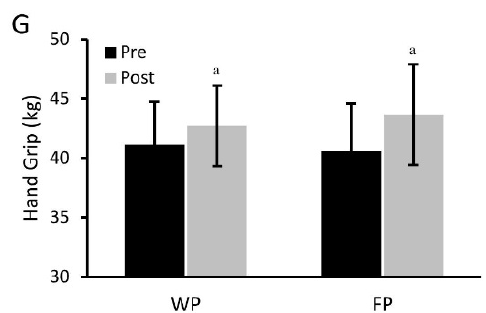
Figure 2. Comparisons of physical performance assessments between the food protein (FP) and the whey protein (WP) groups following the protein-pacing, resistance, interval, stretching, endurance training (PRISE): upper ( A ) and lower body maximal strength ( B ); core ( C ) and upper body muscular endurance ( D ); balance ( E ); flexibility ( F ) and grip strength ( G ). a Significantly different from baseline in each group ( p < 0.01).